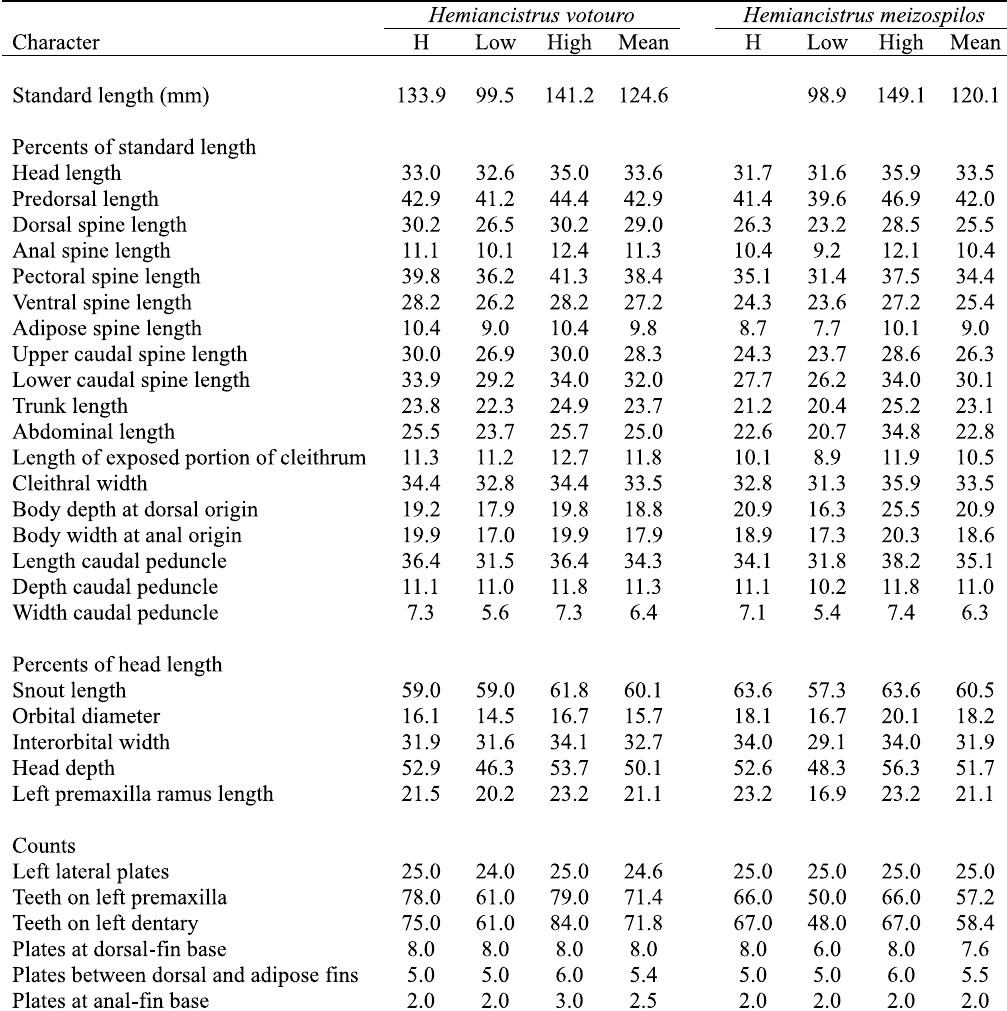
Table 1. Morphometric and meristic characters for the holotype (H) and paratypes of Hemiancistrus votouro (n=8) and Hemiancistrus meizospilos (n=27). Ranges include